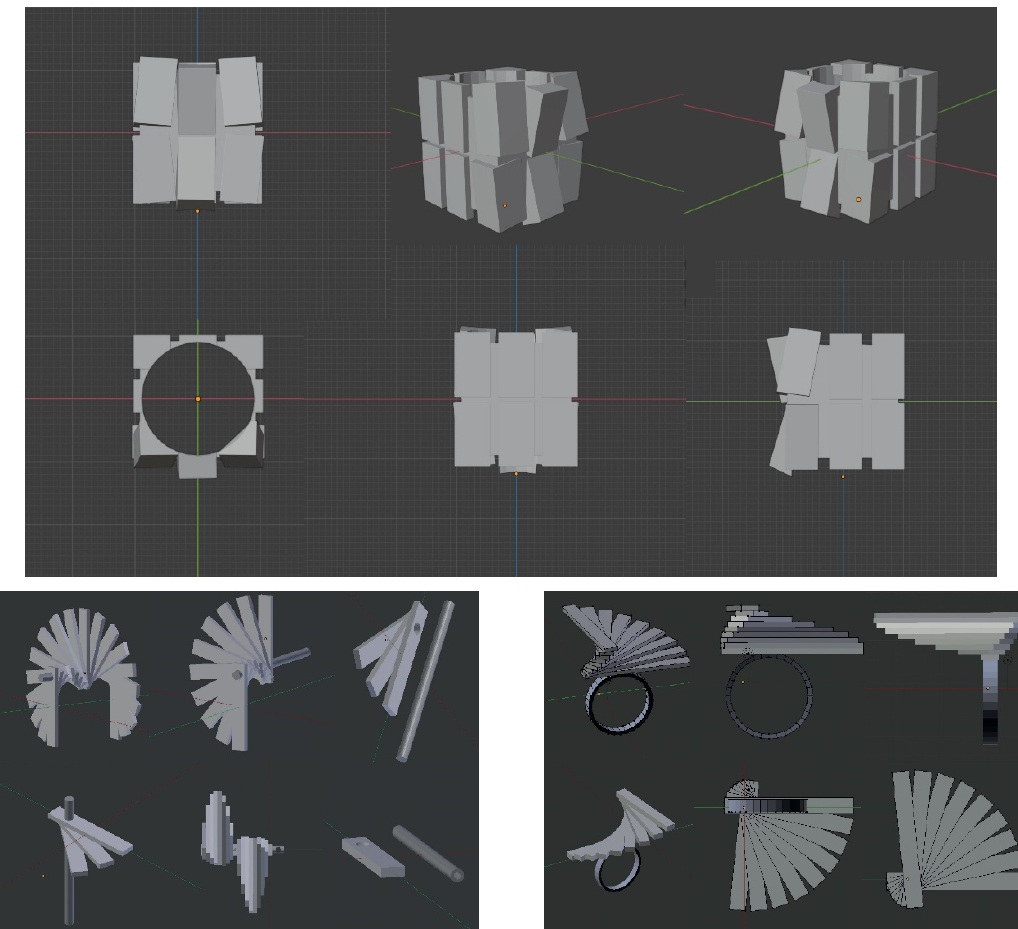
Figure 12. Three-dimensional models of jewellery created in Blender.